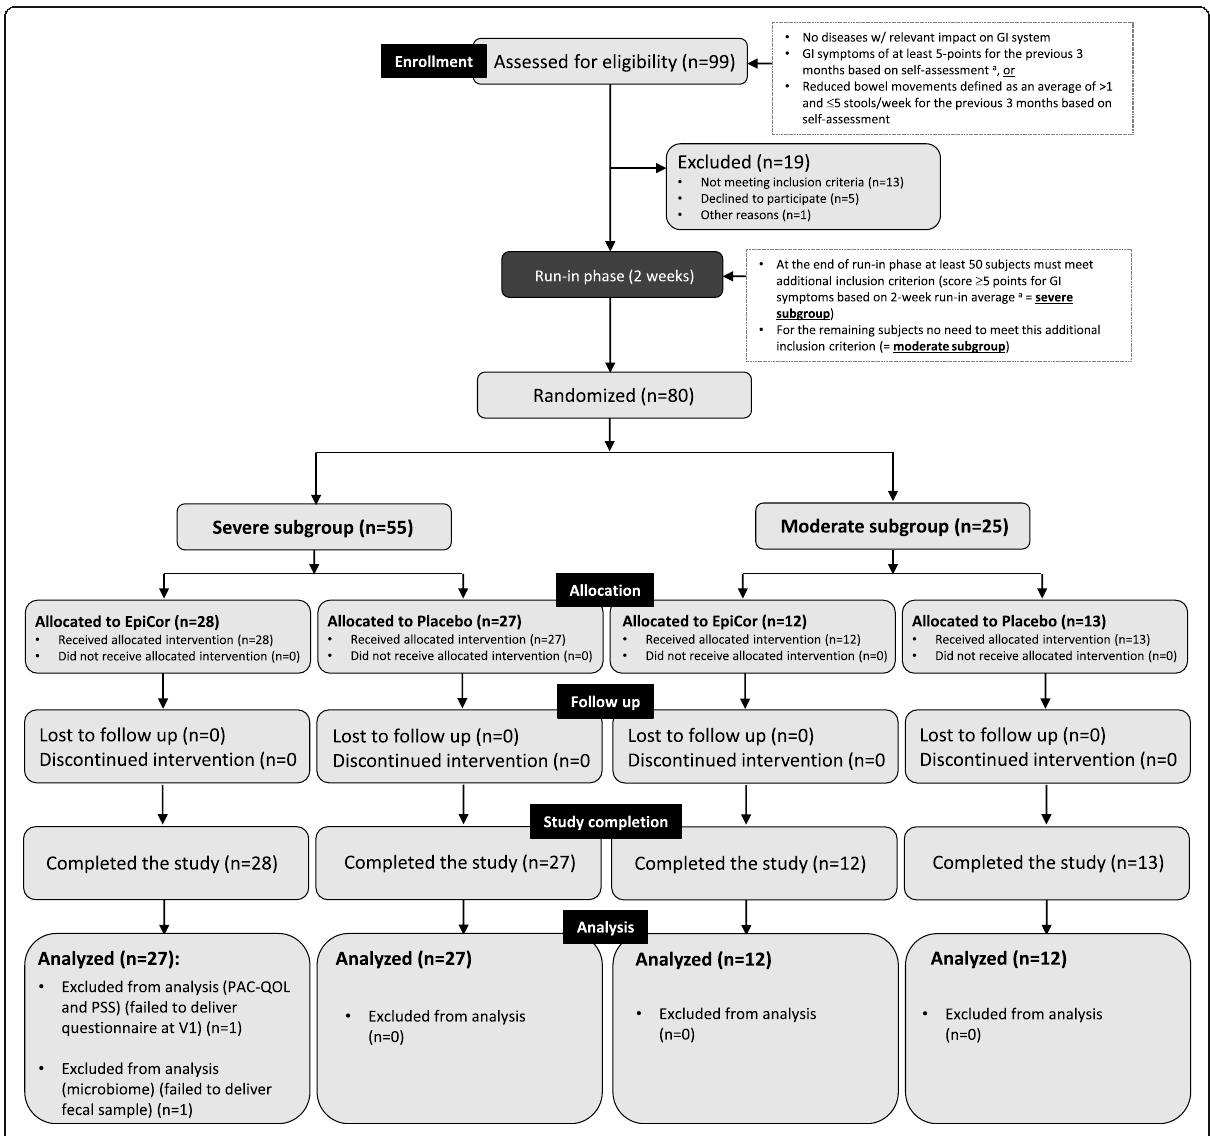
Fig. 1 Schematic diagram of the study flow (based on CONSORT 2010 guidelines). Legend: GI, gastrointestinal; PAC-QOL, Patient Assessment of Constipation Quality of Life; PSS, Perceived Stress Scale. a Gastrointestinal symptoms were assessed by asking the volunteers to grade daily in the evening the average severity over the previous 24 h on a 5-point scale from 0 (not at all) to 4 (extremely) for the following 5 GI characteristics: bloating/distension, passage of gas, GI rumbling, feeling of fullness and abdominal